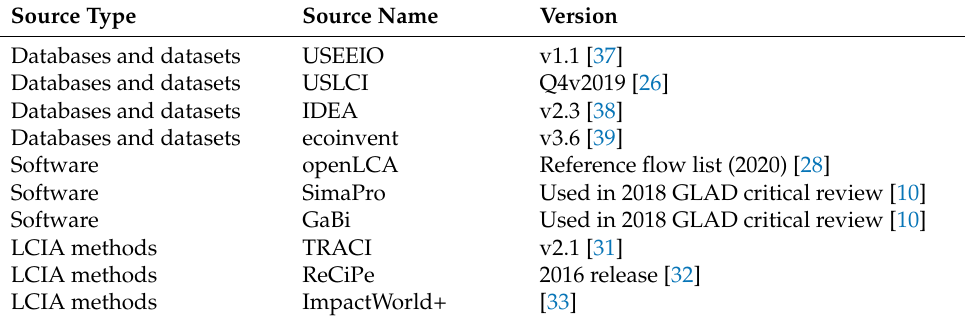
Table 3. Flow list analysis